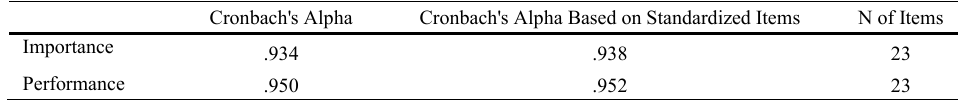
TABLE 5 R ELIABILITY T EST R ESULTS FOR I MPORTANCE AND P